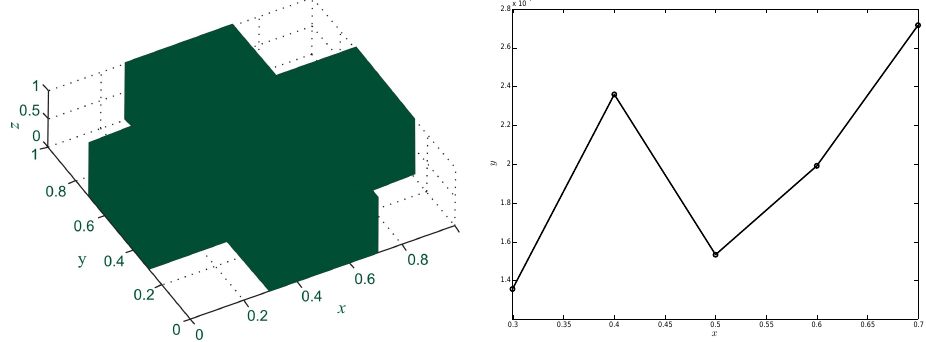
Figure 12. Computational domain ( left ) and L abs error norm on the line x = y = z ( right ) for Problem 5.